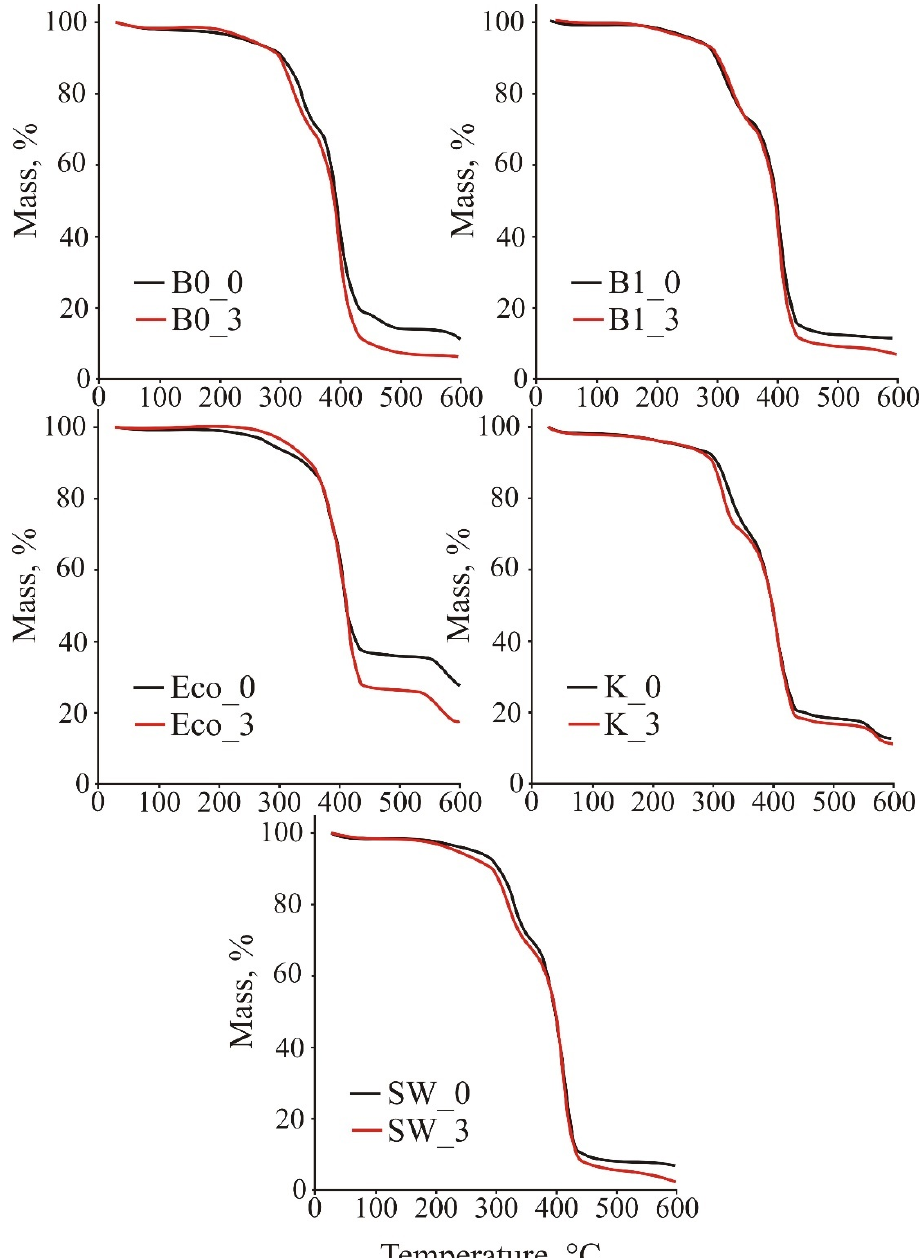
Figure 8. TG curves of tested samples before and after 3 months of decomposition.